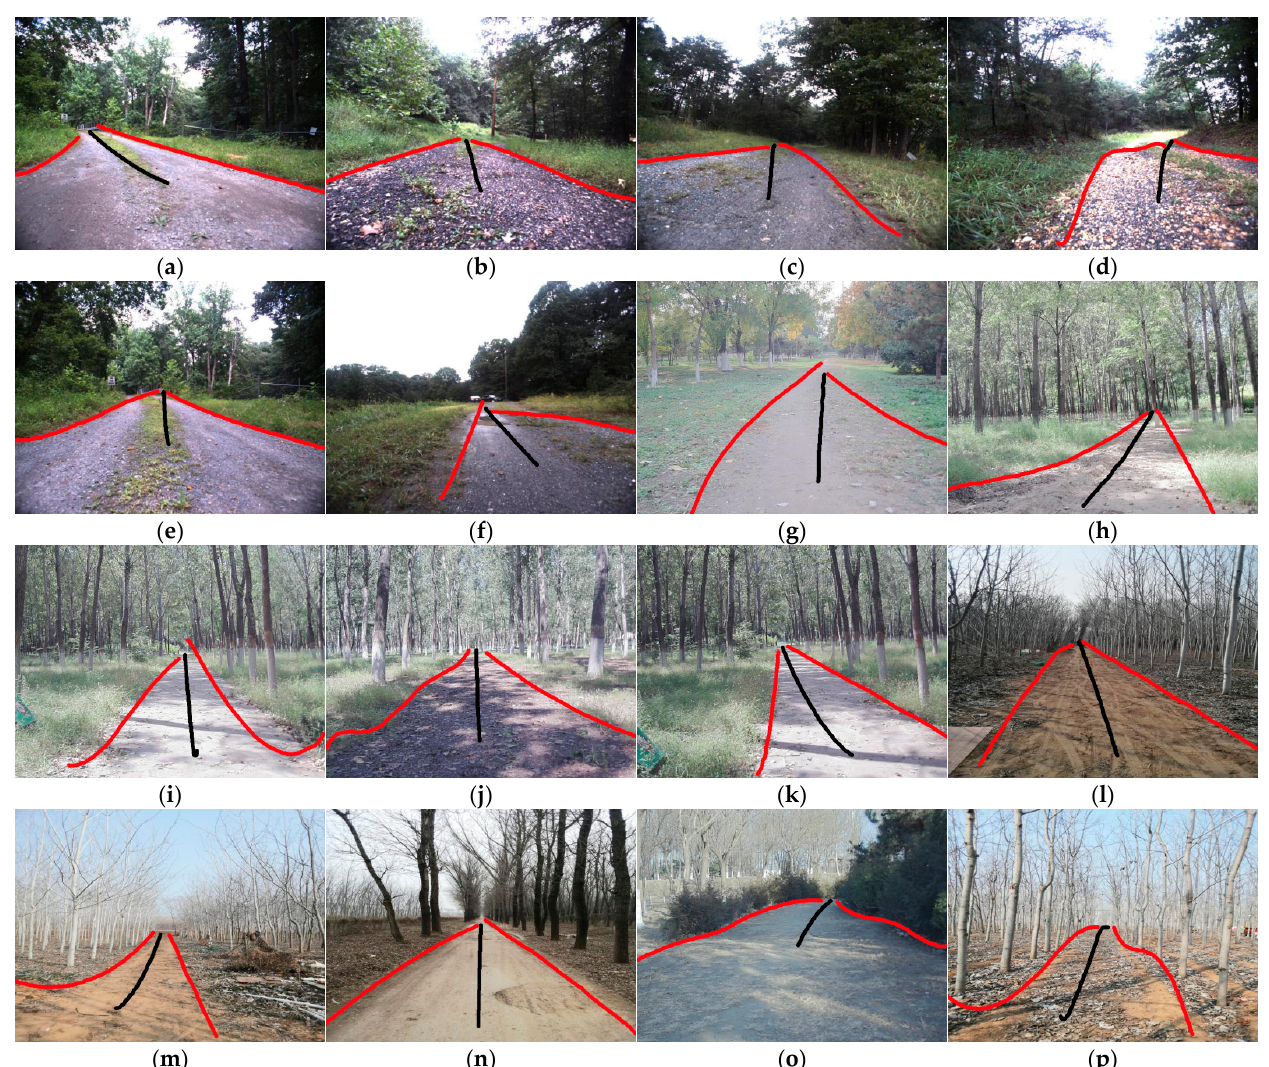
Figure 8. Smooth boundary fitting and road centerline fitting of unstructured roads in forest areas. ( a – f ) are from RUGD; ( g – k ) are from Jiufeng Forest Farm; ( l – p ) are from Liaocheng Forest Farm.